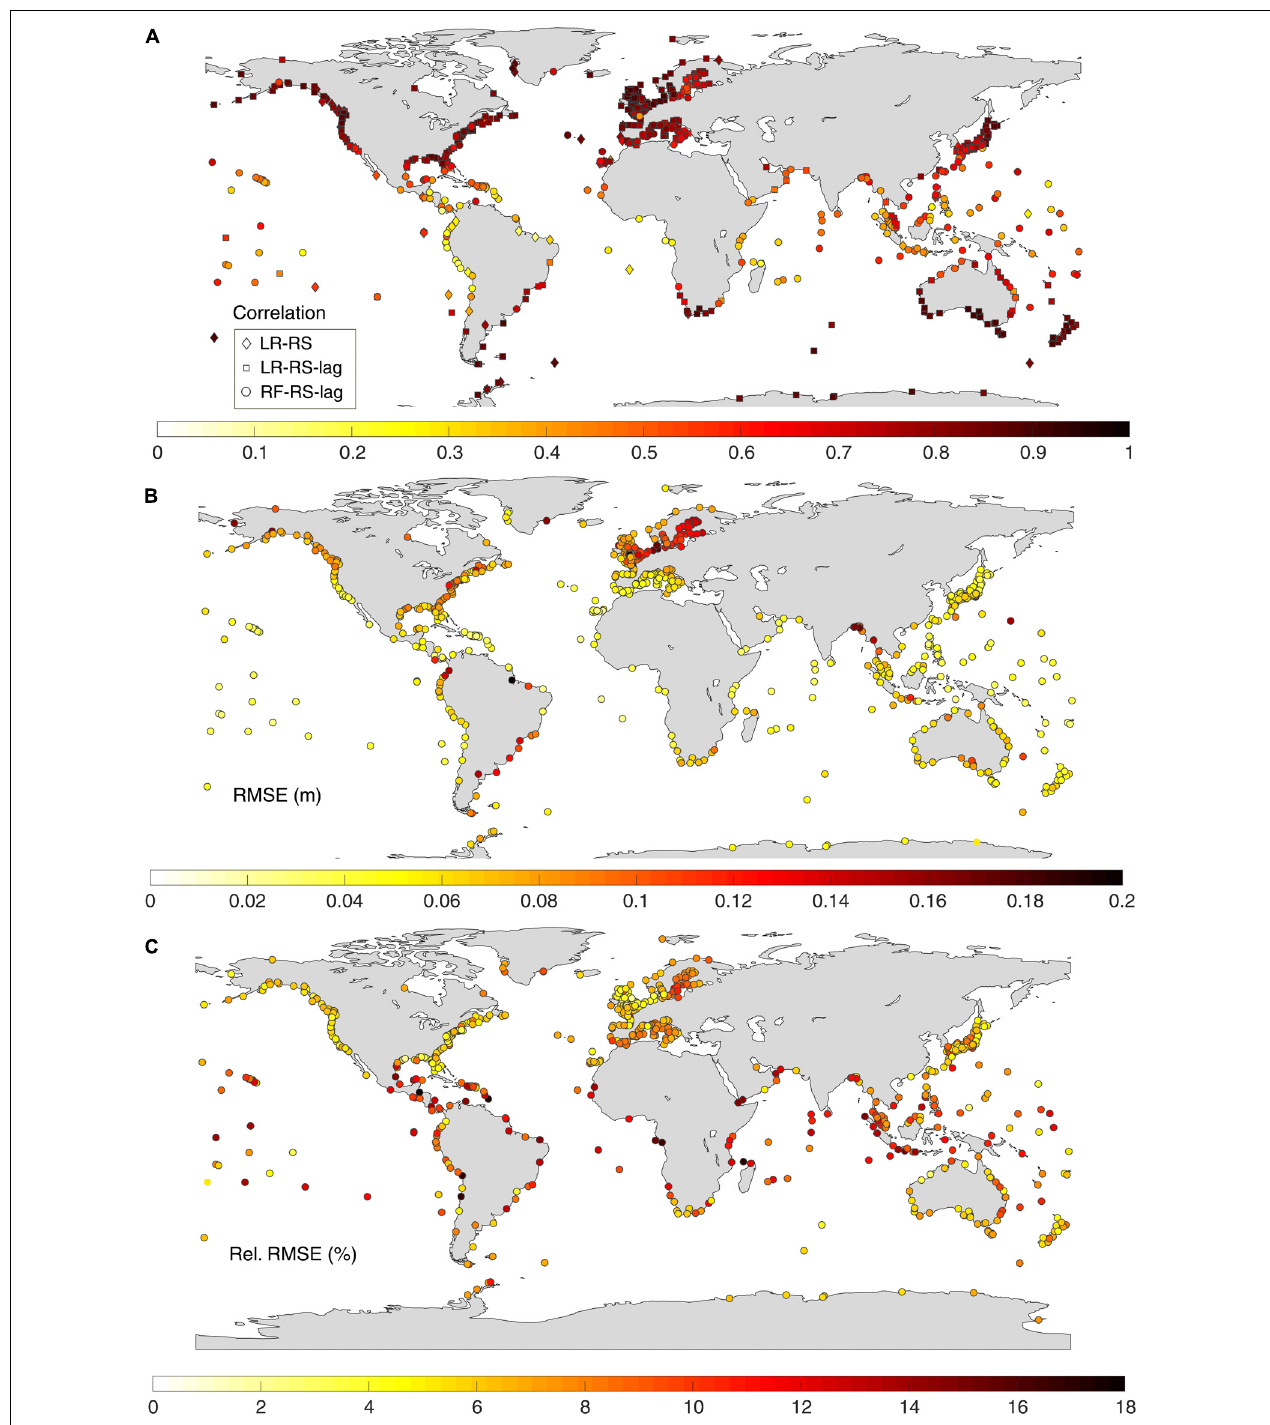
FIGURE 5 | Validation of Model RS in terms of (A) Pearson’s correlation coefficient – diamonds, rectangles, and squares represent the three model configurations (LR-RS, LR-RS-lag, and RF-RS-lag) that make up Model-RS; (B) RMSE in m; and (C) relative RMSE in %.